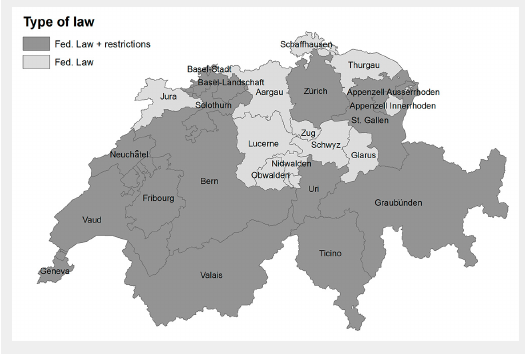
Geographical distribution of the two types of smoking ban implemented in each canton in Switzerland. Fed. Law (light grey): cantons which followed only the Federal Smoking Ban; Fed. Law + restrictions (dark grey): cantons which applied additional restrictions to the Federal Smoking Ban.